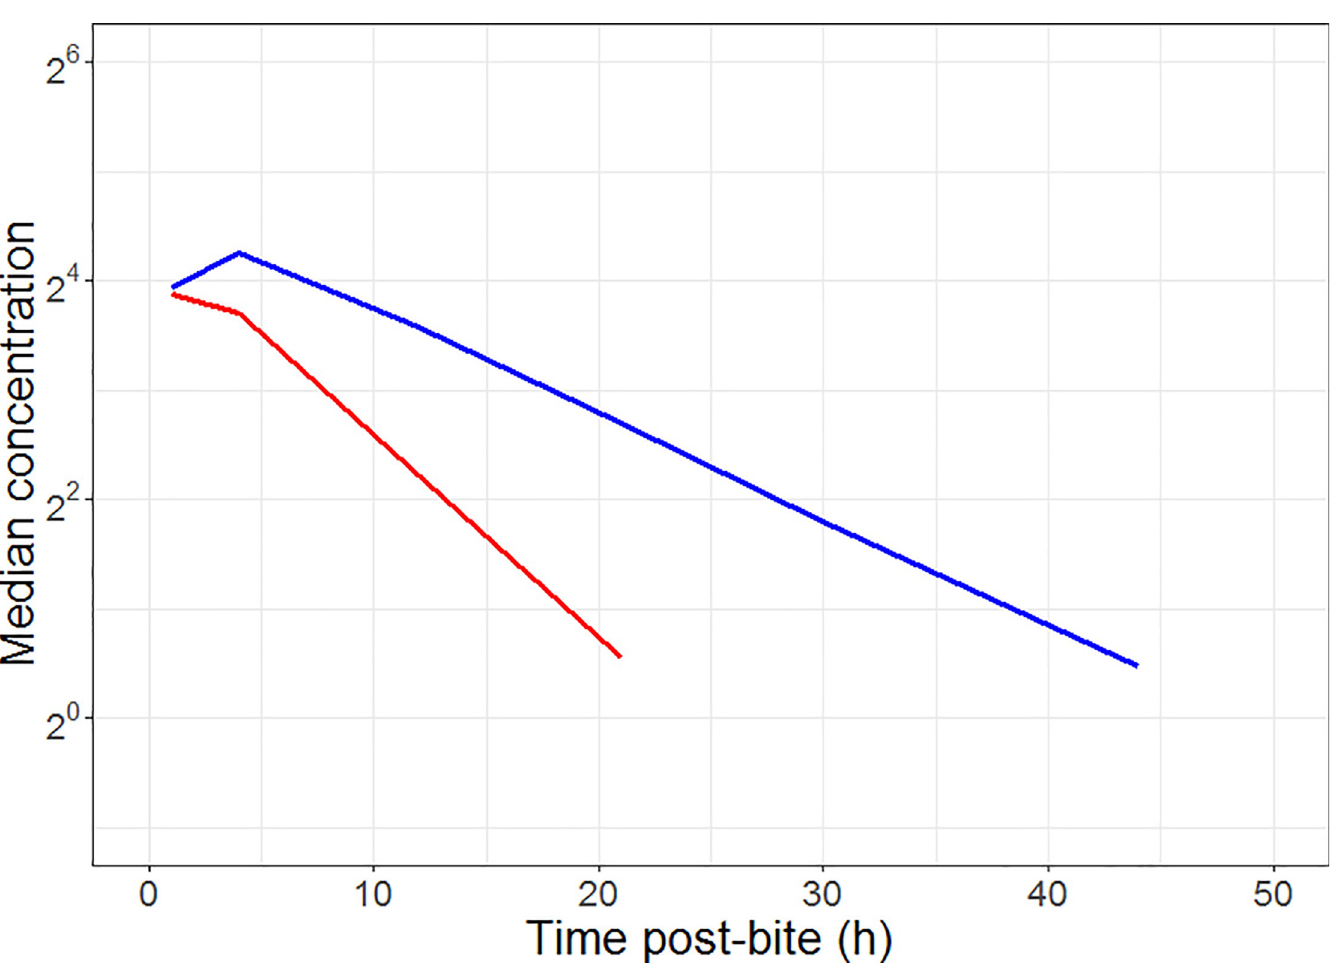
Fig 6. Simulation of venom profile from the population pharmacokinetic model of P . porphyriacus venom (red line) and the putative toxin profile from the final population kinetic-pharmacodynamic model (blue line).